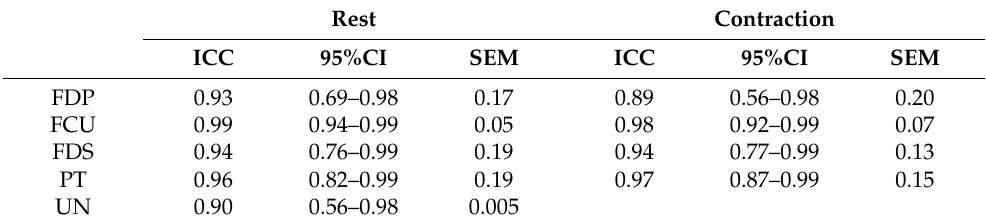
Table 1. Intra-rater reliability (ICC1.2).